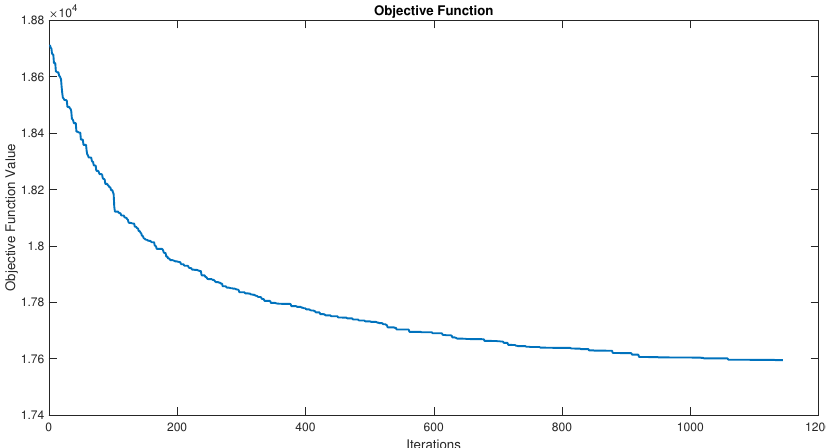
Figure 7. Objective function behaviour of the optimum solution for Region